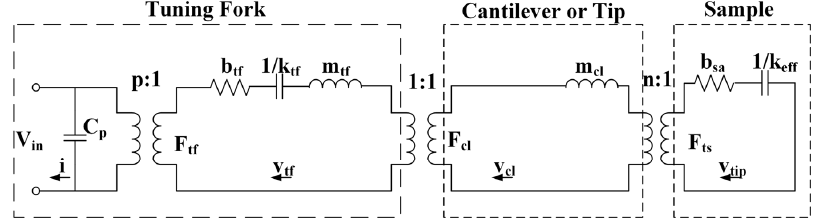
Figure 4. The model of rigid tip.